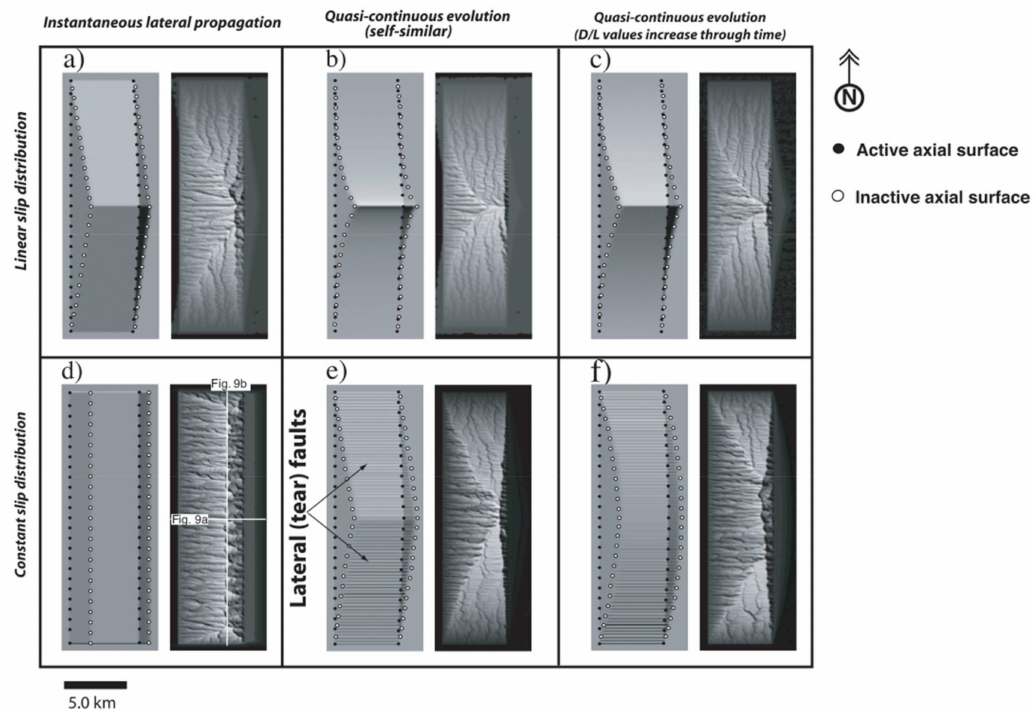
Figure 6. Final morphology of the fault-bend fold model under different slip distributions, ( a – c ) top row linear slip distribution, ( d – f ) bottom row constant slip distribution and for styles of lengthening (columns). Greyscale shaded relief images with illumination from NW, azimuth is 30 degrees.